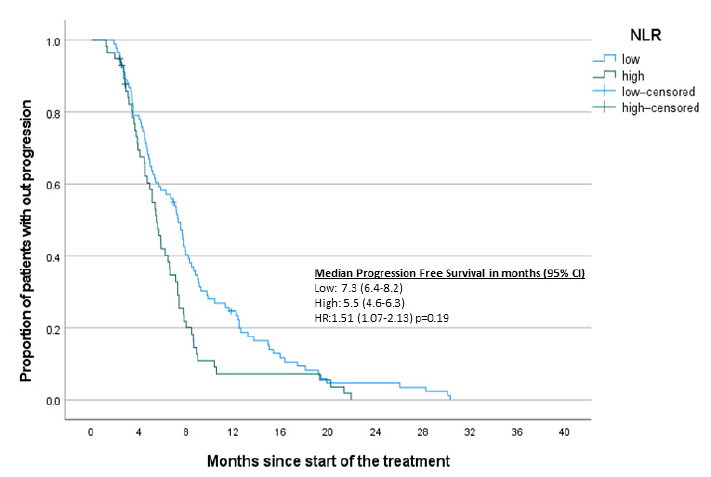
Figure 3. Kaplan–Meier curves for OS-PVPR .